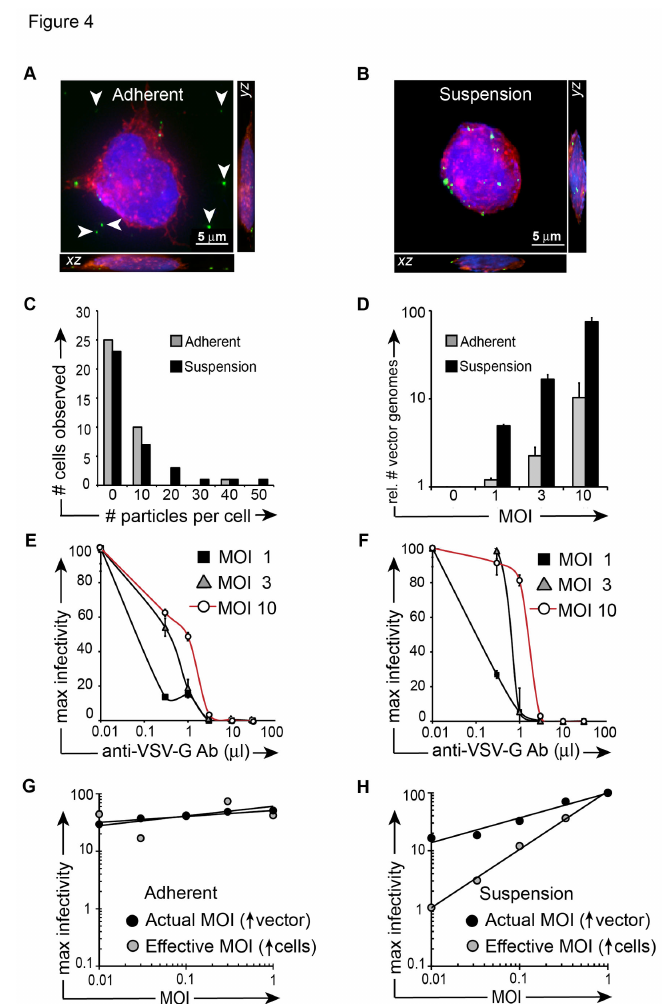
Figure 4. Neutralization is dependent upon cell mobility. ( A ) Merged z -stack of transduced adherent cell shown alongside yz and xz planes. 6.0x10 4 NIH 3T3 cells were allowed to adhere to a chambered well for 3 hours. Cells were then transduced for 30 minutes at 4°C, fixed with 4% paraformaldehyde, washed with PBS, permeabilized with NET buffer, stained with Alexa Fluor phalloidin 555 (red), and DAPI (blue). ( B ) Merged z -stack of transduced suspension cell shown alongside yz and xz planes. 6.0x10 4 NIH 3T3 cells were prepared as described in (A) with the exception that cells were transduced following 3 hours of suspension culture in polystyrene tubes instead of plating in adherence to chambered wells. Once cells were fixed and stained, they were placed in chambered wells for microscopy. Scale bars in (A), (B) are 5 µm. ( C ) The experiment described in (A) and (B) was performed twice and the average number of particles per cell was determined by counting particles in 36 cells per cohort. The frequency of cells observed to have a specific number of particles bound to the cell surface was calculated using Microsoft Excel. ( D ) NIH3T3 cells were exposed to increasing concentrations of vector as in (C), cells were immediately fixed, then cDNA was synthesized, and quantitative RT-PCR was performed with primers that amplified GFP (vector) or GAPDH. The relative quantitation of GFP (i.e. vector genomes) is shown on the y -axis. ( E ) 293T cells were allowed to adhere to tissue culture-treated plates for at least 4 hours (“Adherent”, left), or were left in suspension ( F ) in polypropylene tubes (“Suspension”, right). Cells were transferred to 4C for 1 hour, followed by a 1-hour vector exposure (MOI 0, 1, 3, 10). Following vector exposure, cells were transferred to 37 o C and serial concentrations of anti-VSV-G neutralizing antibody were added to the media. FACS was performed 72 hours later. ( G ) Vector was added to pre-plated 293T cells in serially increasing concentrations while media volume and cell number remained constant (actual MOI, black circles). Increasing numbers of 293T cells were plated on 12 well poly-L-lysine-coated plates, while keeping vector concentration and media volume constant (effective MOI, gray circles). Cells were washed after 4-hour vector exposure in the presence of 4 µg/ml protamine sulfate. FACS was performed 72 hours later. ( H ) The experiment was performed as described in (G) with the exception that 293T cells were kept in suspension during 3-hour transduction in polystyrene tubes. Cells were then washed and transferred to 12-well plates. FACS was performed 72 hours